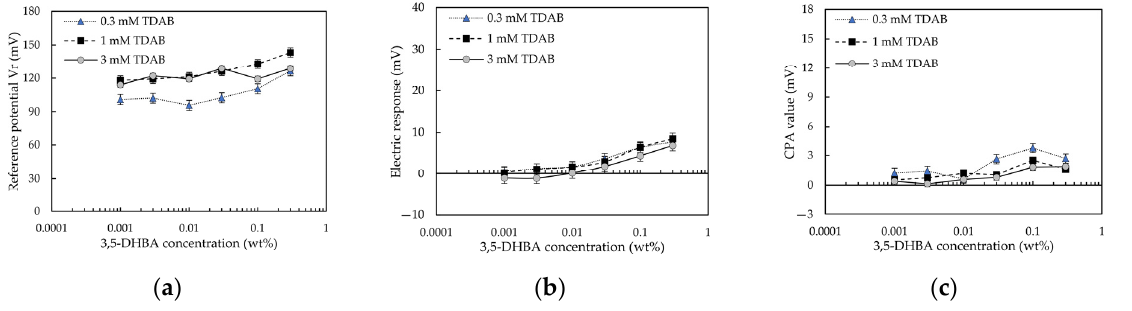
Figure 9. The 3,5–DHBA-concentration-effect curves for 100 mM caffeine, using the taste sensor with lipid/polymer mem- brane (0.3, 1, and 3 mM TDAB): ( a ) change in reference potential; ( b ) change in electric response; and ( c ) change in CPA value.